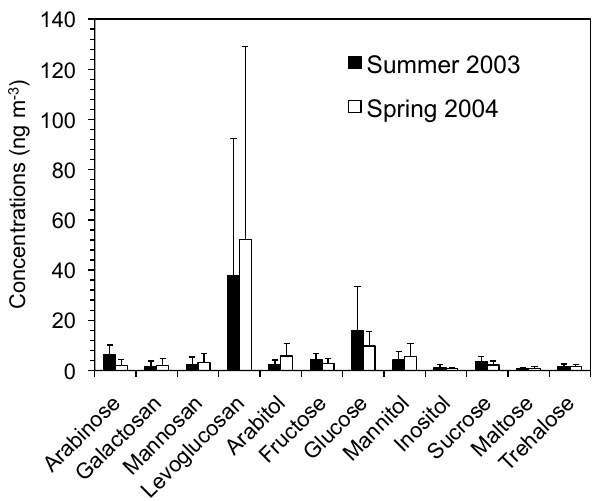
Fig. 5. Molecular distributions of sugar compounds detected in the aerosol (PM 10 ) samples collected during aircraft campaigns in sum- mer 2003 and spring 2004.